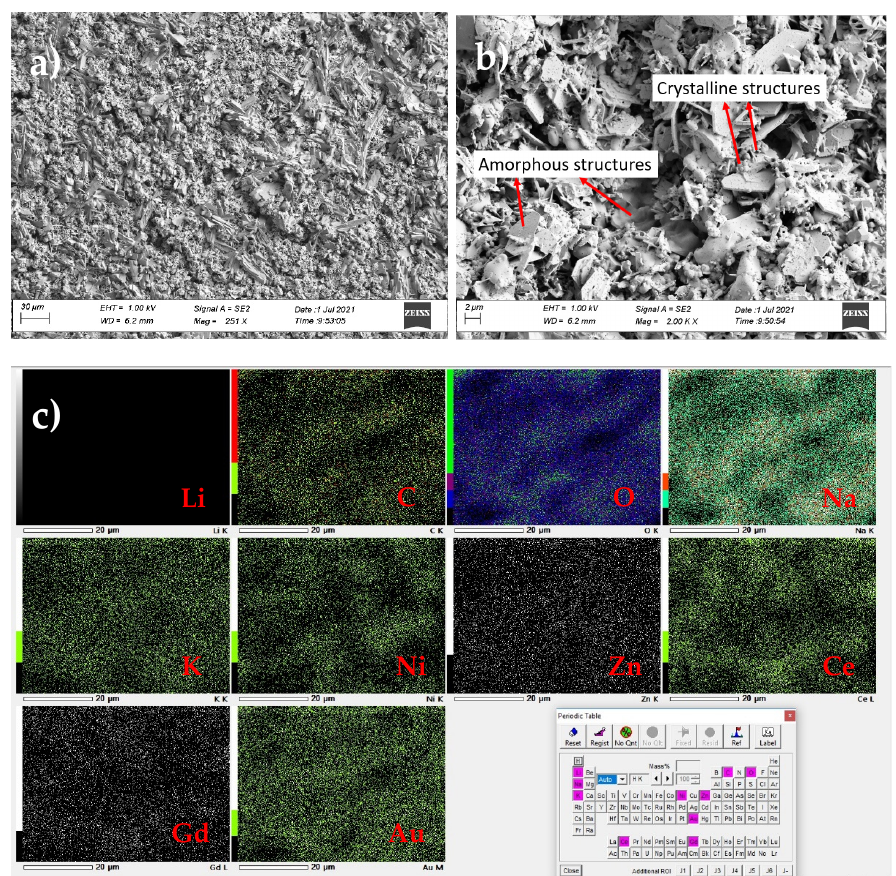
Figure 7. SEM images of the printed single-layer cell sintered at 900 °C: ( a ) at low magnification (251×), ( b ) at high magnification (2000×), ( c ) EDS mapping on the SEM image. Table 3. Elemental concentration of the printed single-layer cell shown in Figure 7. ND represents “no data”.